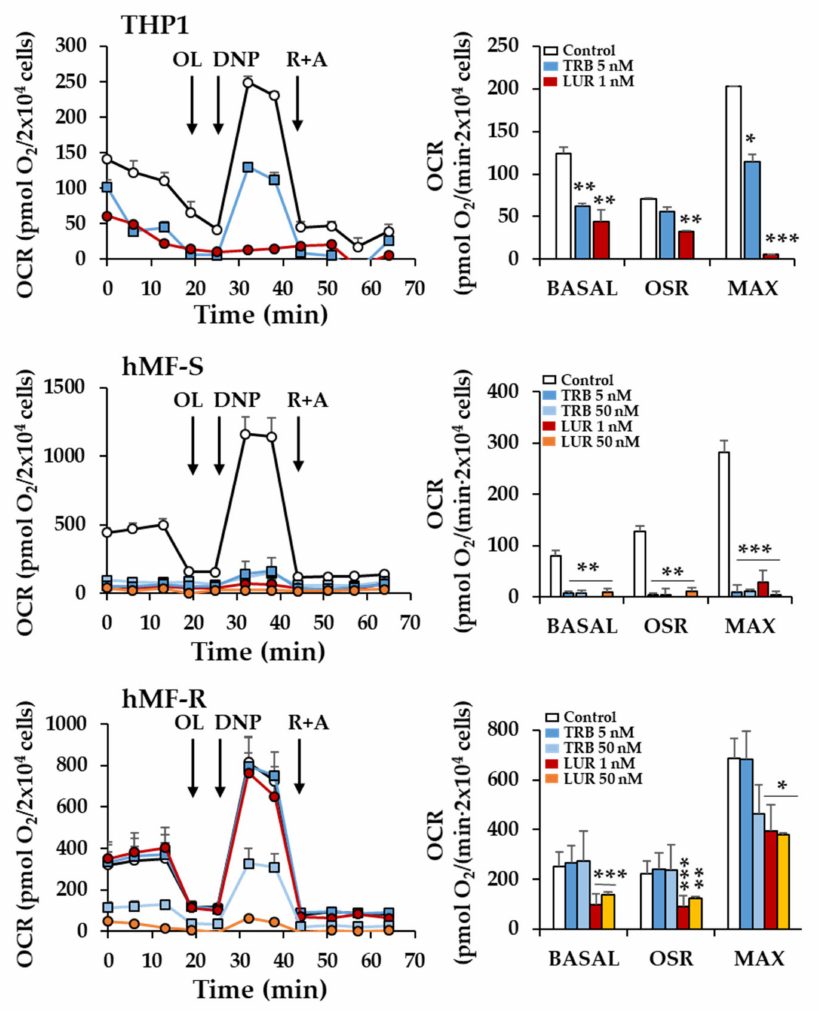
Figure 4. E ff ect of TRB and LUR in THP-1 and hMF oxygen consumption rate (OCR) after 24 h of treatment. hMF (2 × 10 4 cells) were treated with the indicated concentrations of drugs. At the indicated times oligomycin (OL), 2 (cid:48) ,4 (cid:48) -dinitrophenol (DNP), and rotenone plus antimycin (R + A) were added. (Right panels) basal respiration (BASAL); OSR (oligomycin sensitive respiration); MAX (maximal respiration). Results show the means + S.E.M. from three THP-1-independent experiments by triplicate and from 7 di ff erent healthy donors by triplicate. * p < 0.05; ** p < 0.01; *** p < 0.001 vs. the vehicle